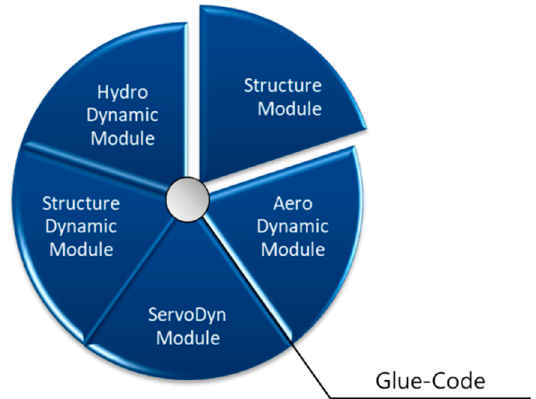
Figure 2. The concept of the interchange substructure module of the FAST V.8 program.